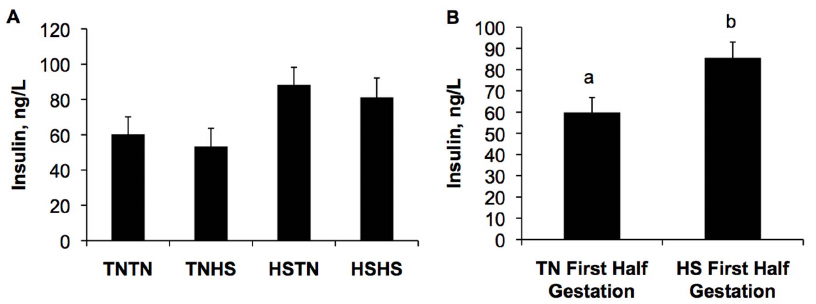
Figure 5. Effect of gestational treatment on circulating insulin concentrations at the end of the chronic treatment period, regardless of postnatal thermal treatment. A) Gestational treatment had a tendency to affect circulating insulin concentrations ( P= 0.0.09). B) Circulating insulin concentrations were elevated in pigs from dams exposed to heat stress (HS) conditions during the first half of gestation compared to those from dams gestated in thermal neutral [30] conditions during the first half of gestation ( P= 0.01). Different letters indicate P , 0.05.